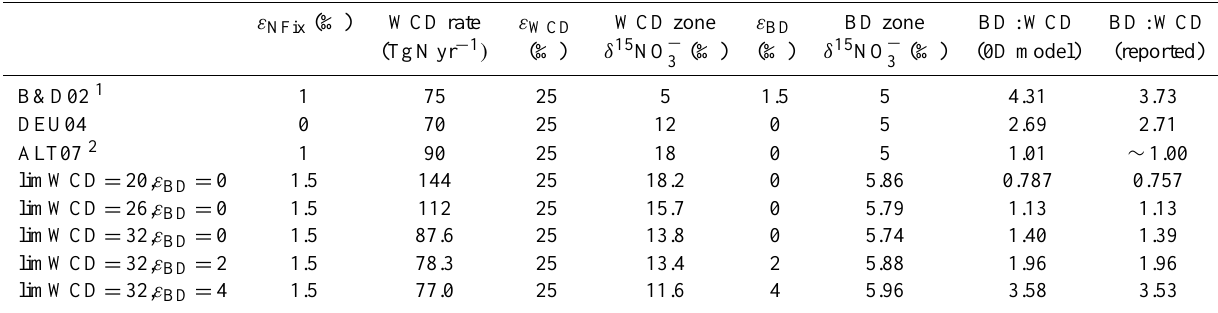
Table 4. δ 15 N box model parameter